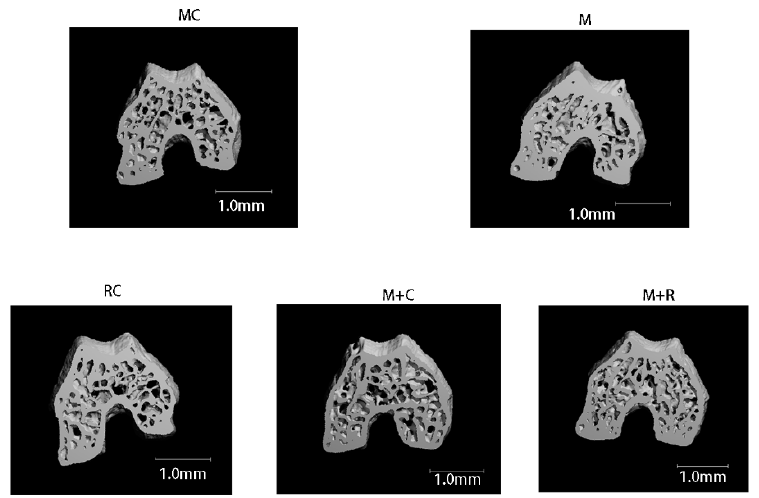
Figure 3. 3D reconstruction of the subchondral bone of the femoral condyle by micro-CT. Table 5. Morphological changes of subchondral bone in the femoral condyle of knee joint. Group